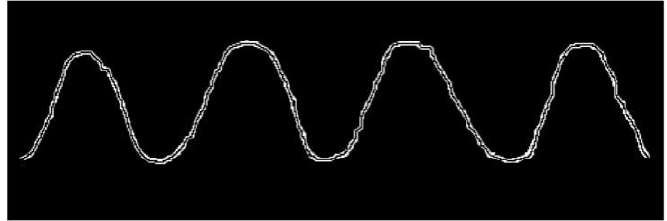
Figure 10. Results of image processing with the operators infill , skel , dilate , bwperim , shrink